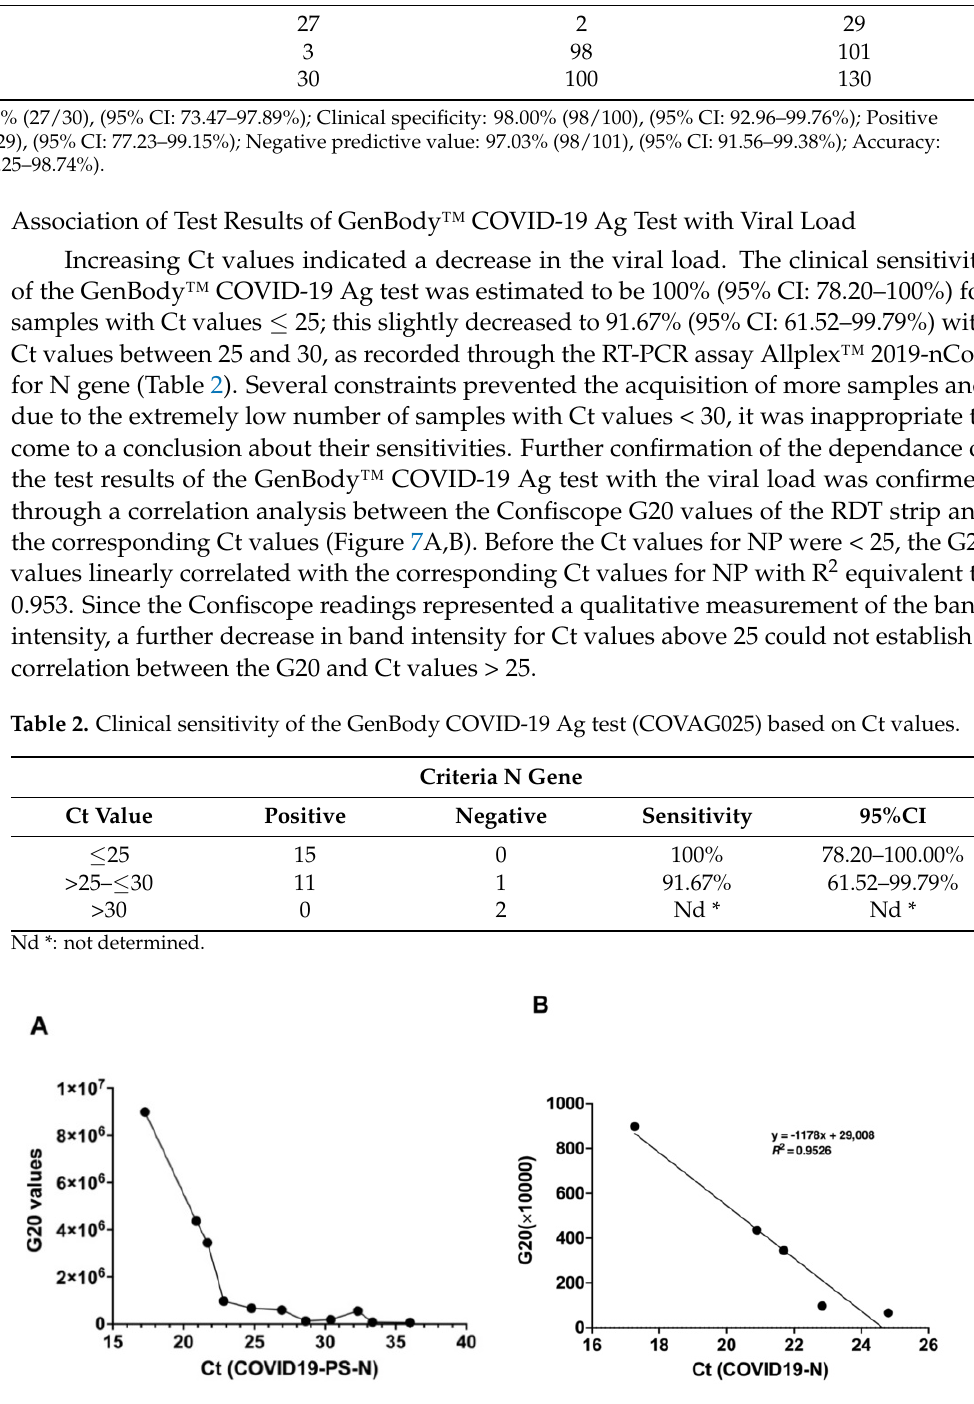
Figure 7. Correlation analysis of G20 values of RDT strip with the corresponding Ct values (SARS- CoV-2-N gene) of the samples. ( A ) Inter-dependance between G20 values and Ct values, ( B ) linear regression analysis.